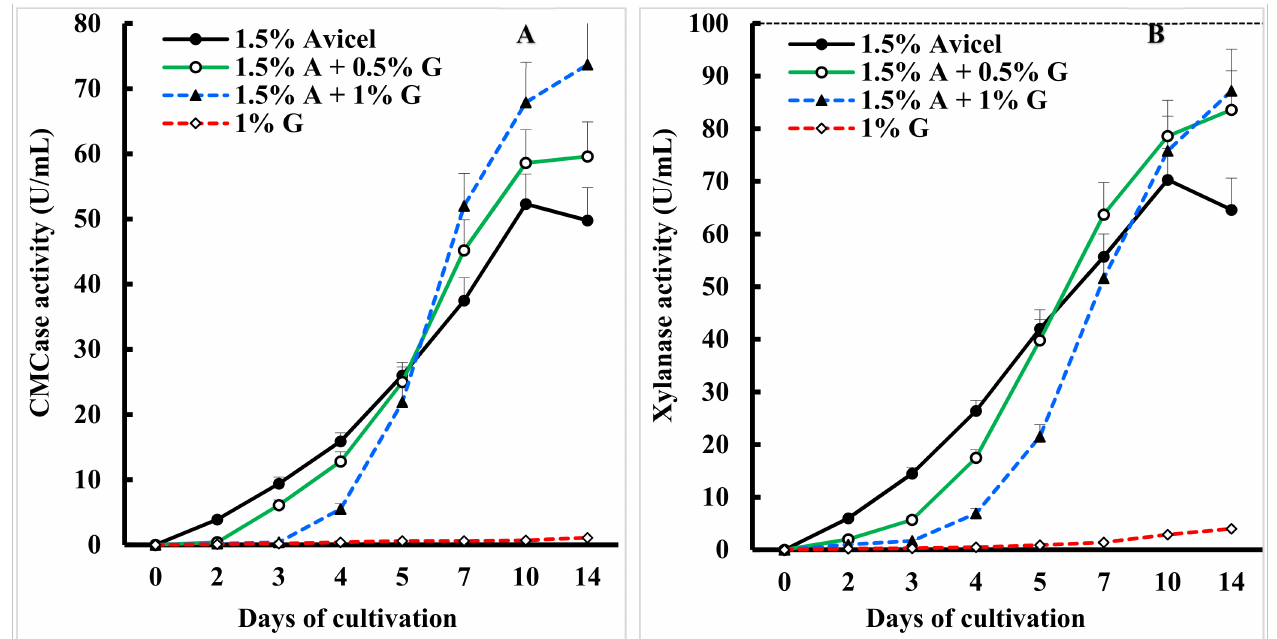
Figure 1. Effect of glycerol (G) as an additional carbon source on the production of endoglucanase ( A ) and xylanase ( B ) during submerged fermentation of Avicel by I. lacteus